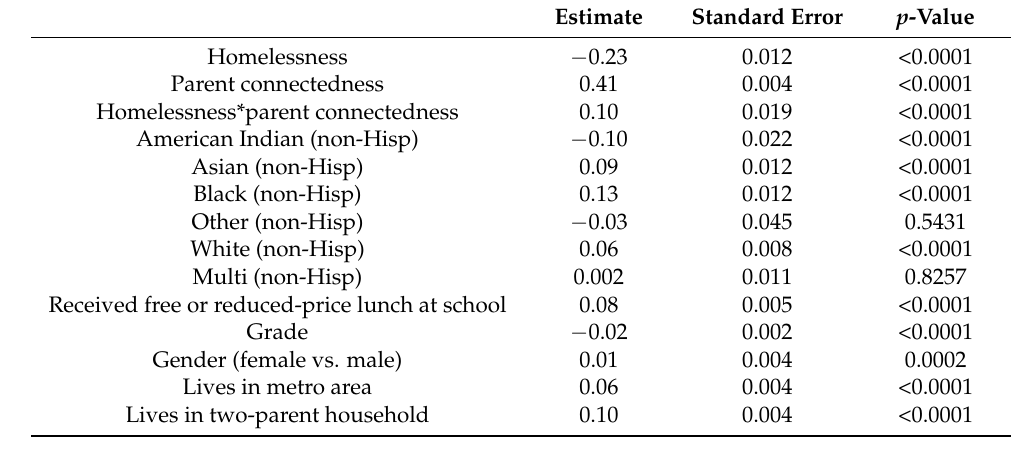
Table 2. Multivariate model.